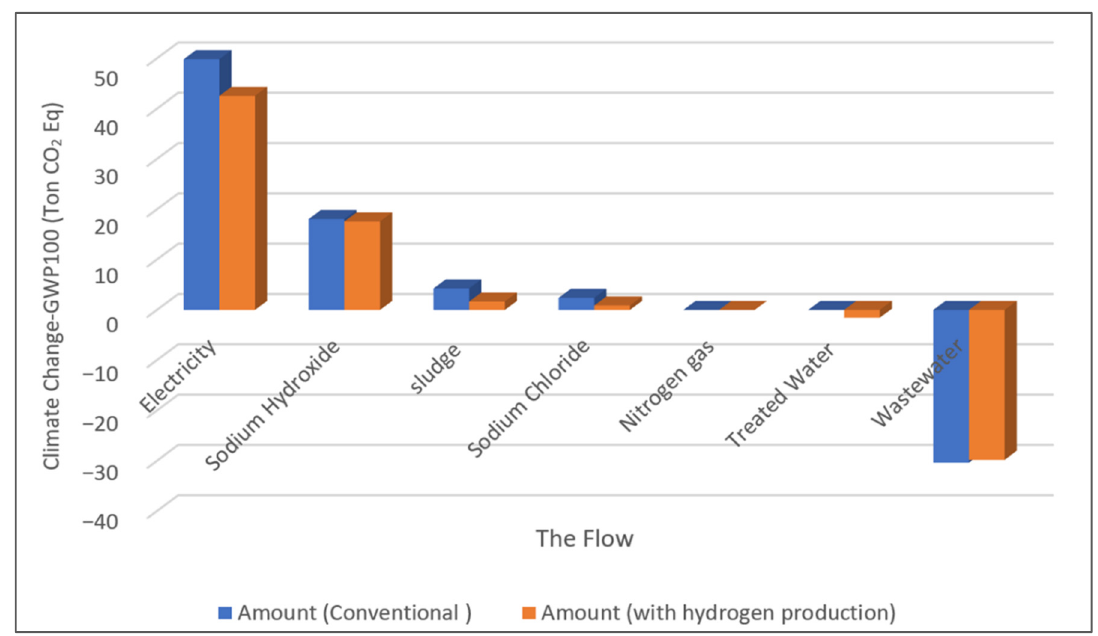
Figure 8. Main sources of climate change impact.